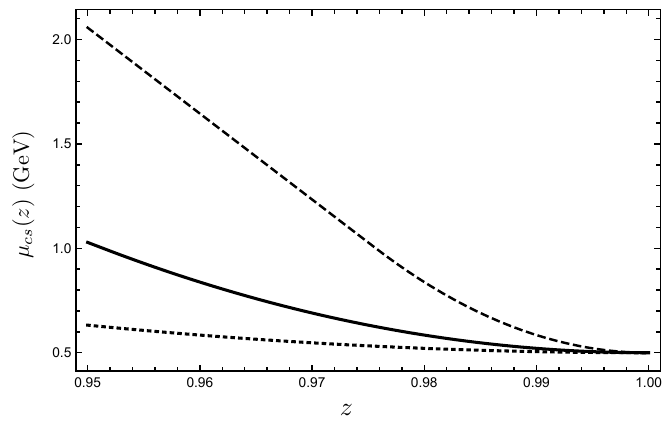
Figure 11 . The profile function for the z -dependent csoft scale as appears in eq. (3.45) where p B = E 2 R 2 + m 2 with E J = 50 GeV, m = 4 . 8 GeV, and R = 0 . 4 . Here µ min is set to be 0 . 5 GeV. J The solid, dashed, and dotted curves correspond to µ 0 = B , 2 B , and B/ 2 ,